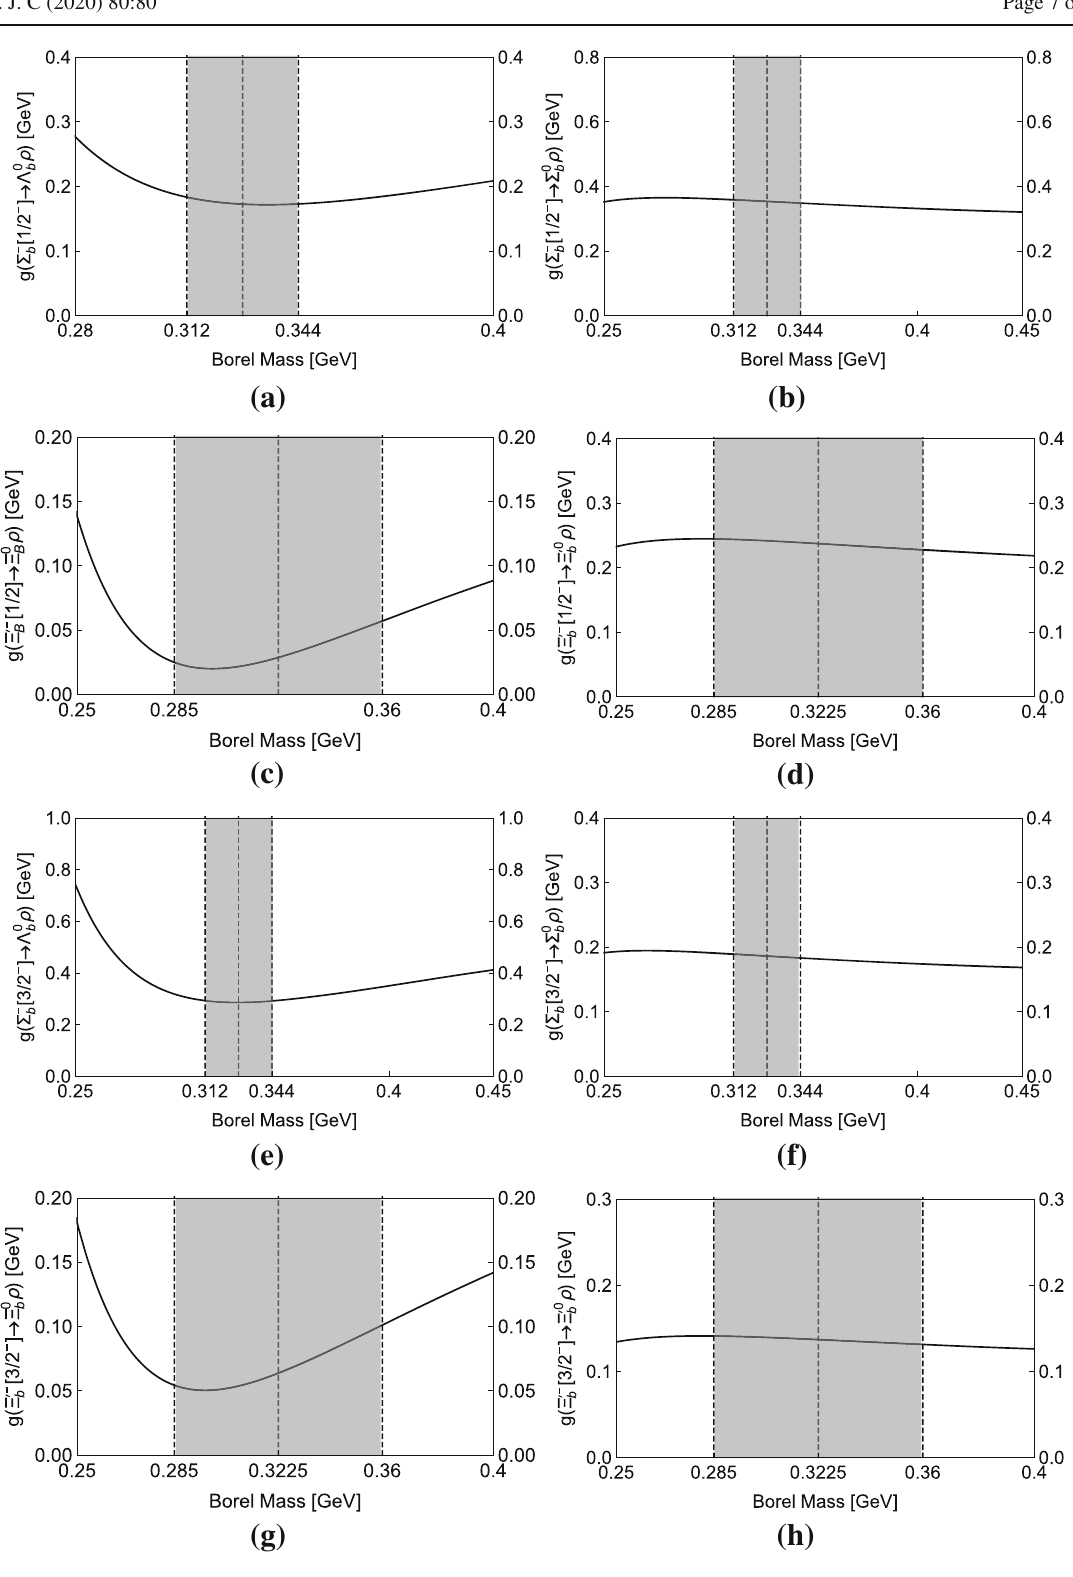
Fig. 2 The coupling constants a g c g , d g − ]→ Ξ 0 Ξ (cid:4)− [ 1 ρ − b b 2